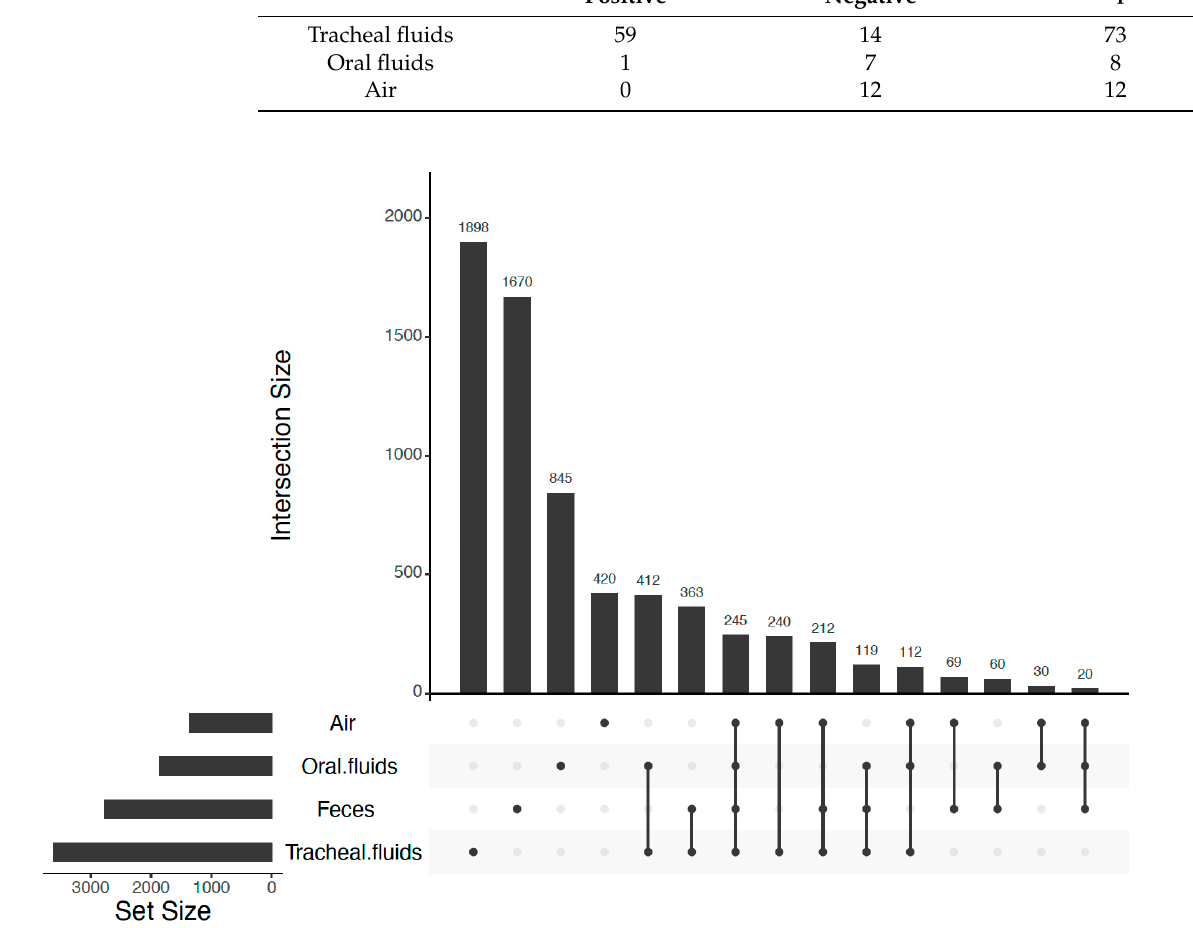
Figure 1. Amplicon sequence variants (ASVs) shared among sample types. Intersection size: number of ASVs comprising a specific nonoverlapping set. Dark circles indicate the sample types that are part of the set. Dark circles connected by a line indicate that two or more sample types are part of the set. The plot was made using UpSetR package in R [47] with the layout described by Lex and Gehlenborg [48]. Table 2. Five most abundant bacterial genera identified in microbial communities from various fluids and samples.